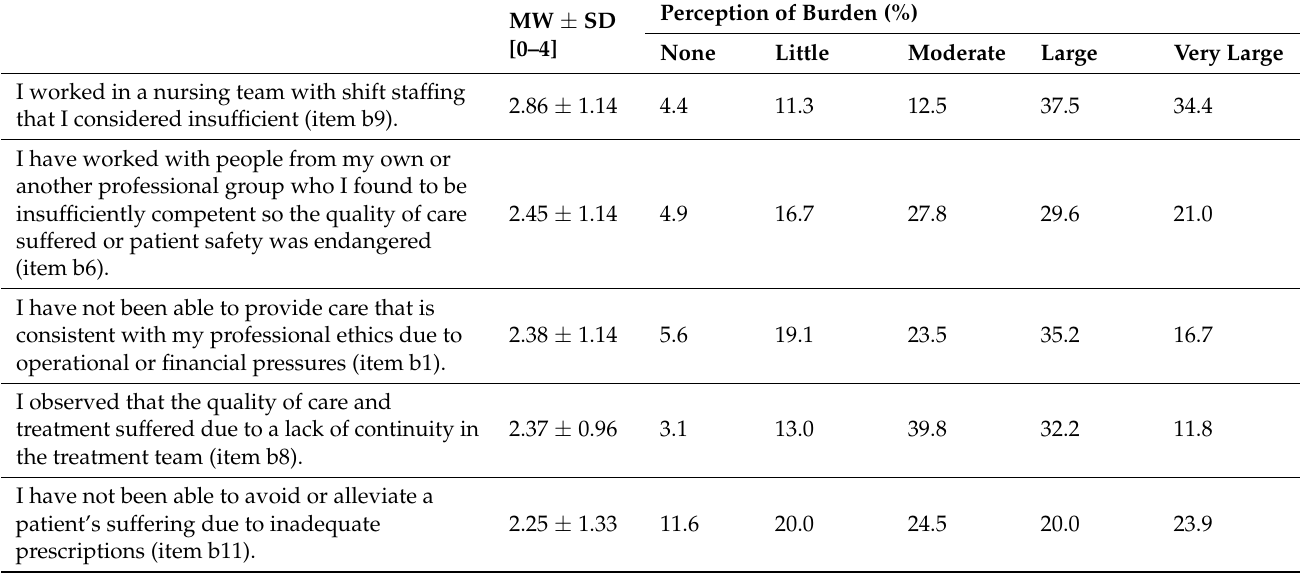
Table 1. Particularly stressful situations for